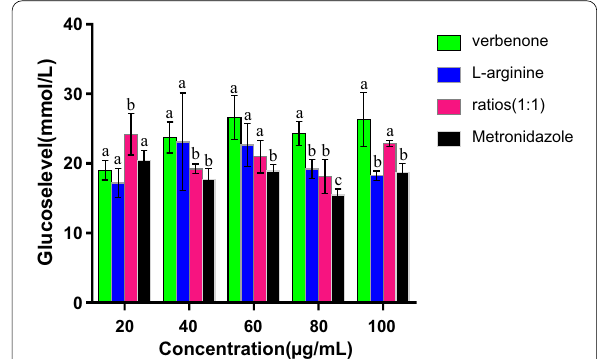
Fig. 4 Glucose uptake activity by yeast cell treated with verbenone, L-arginine and ratios of verbenone L-arginine (1:1 v/m). Values are + expressed as mean SEM, triplicated determinations. Values with ± different superscripts are significantly different at p < 0.05. Ratios (1:1) verbenone L-arginine (1:1 = +